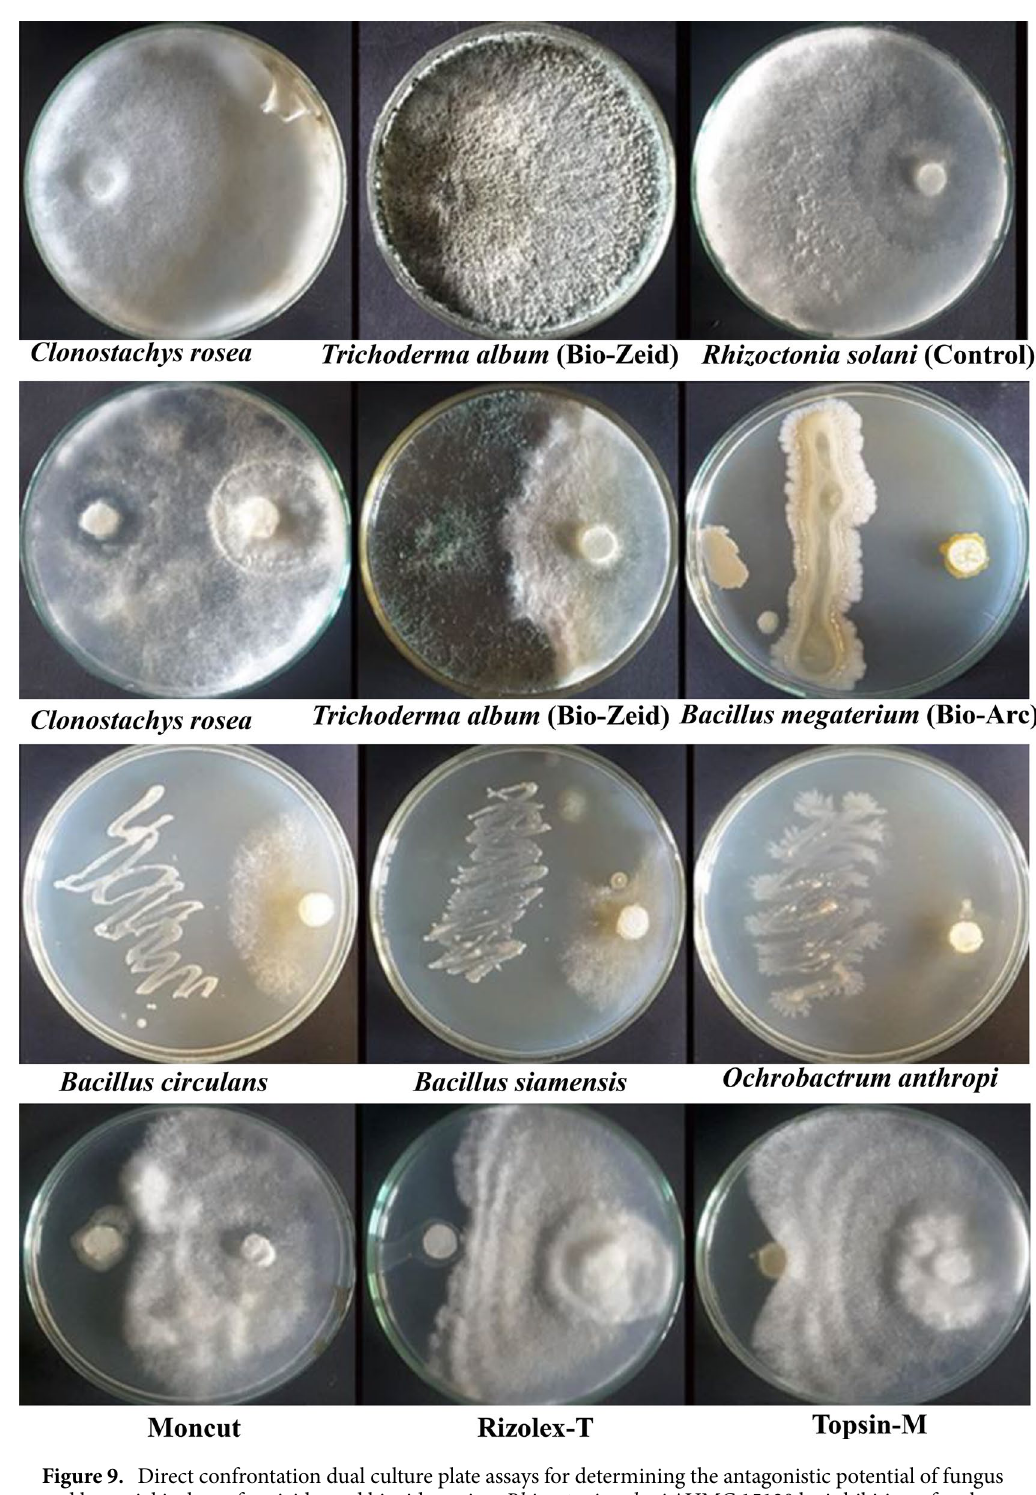
mycelial growth compared to the untreated control plates in vitro. The cultures were incubated at 26 ± 2